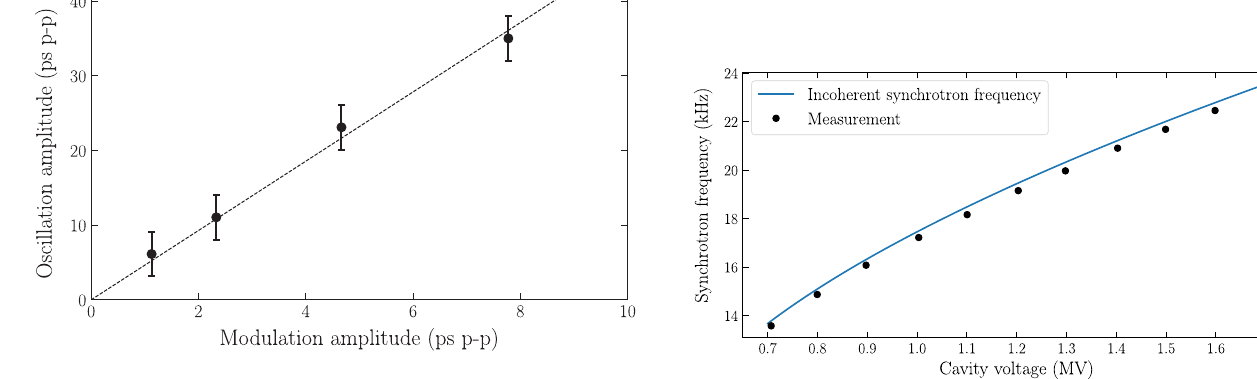
FIG. 18. Measured coherent synchrotron frequencies at a low beam current of 5 mA as a function of the cavity voltage. Solid line indicates the calculated incoherent